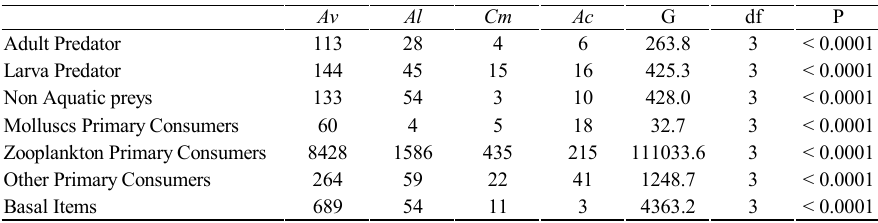
Table 2. Categorized diet items for A. viarius ( Av ), A. luteoflamulatus ( Al ) , C. melanotaenia ( Cm ) and A. cheradophylus ( Ac ). The preys were classified in Basal items, Primary Consumers (PC: Zooplankton, Molluscs and Other), Predators (P: Adult and Larva), and Non Aquatic items. For each item it is provided the result of G-test (G), the freedom degree (df) and the probability (P), for differences in